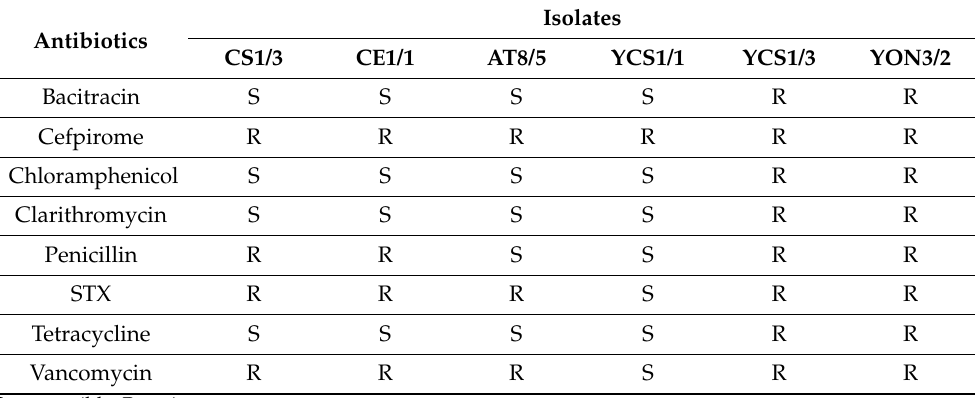
Table 6. Antibiotic resistance of the selected